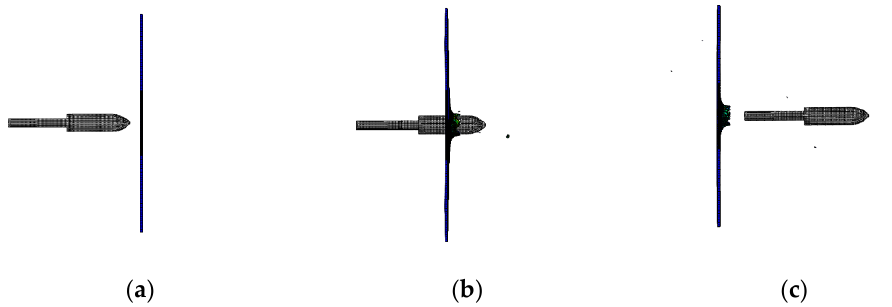
Figure 8. Simulation results for a launch speed of 56 m/s: ( a ) before penetration; ( b ) penetrating; ( c ) after penetration.